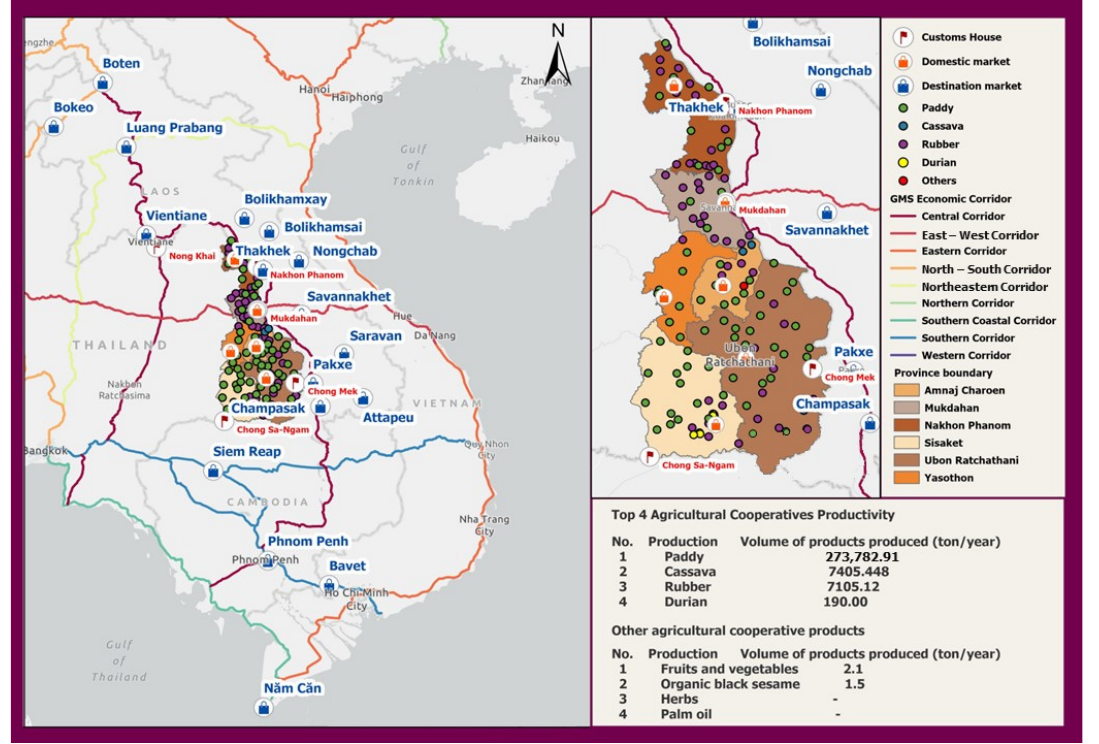
Figure 2. Proposed problem definition [7] (Sources: ESRI, HERE, Garmin, FAO, NOAA, USGS, OpenStreetMap contributors, the GIS user community and Projection UTM WGS1984 Zoon 48N).